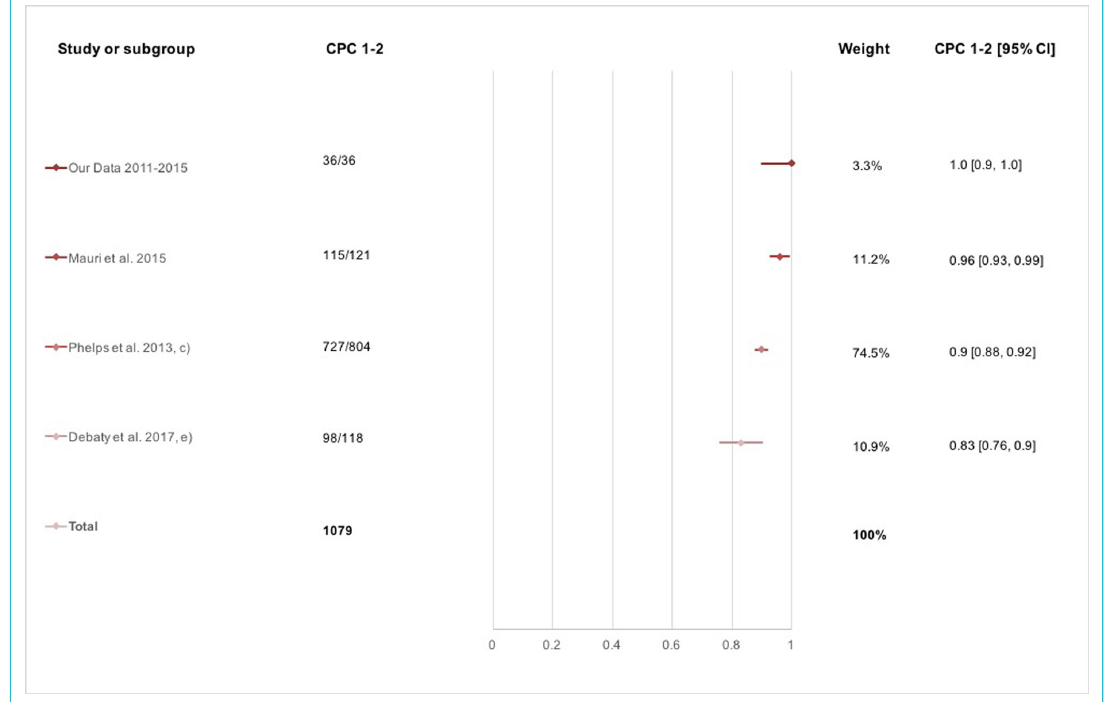
Figure 6: CPC score at 1 year post-arrest.* Outcomes are reported according to Utstein (cardiac aetiology, witnessed [layperson or EMS] and shockable initial rhythm), if not mentioned otherwise: (c) includes non-witnessed, non-shockable; (e) includes non-cardiac, non-witnessed, non-shockable, excludes